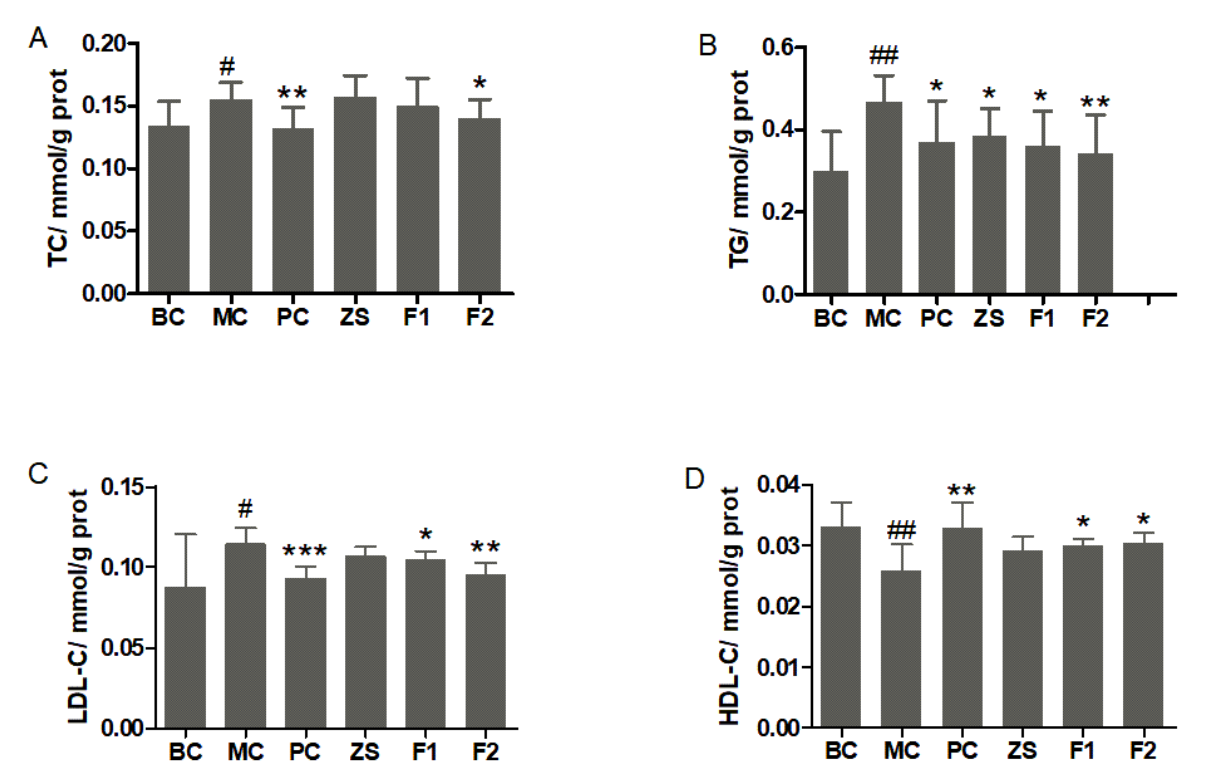
FIGURE 2 - Effect of BCLE on lipid levels in the liver of KK-A y mice (data are expressed as means ± SD)